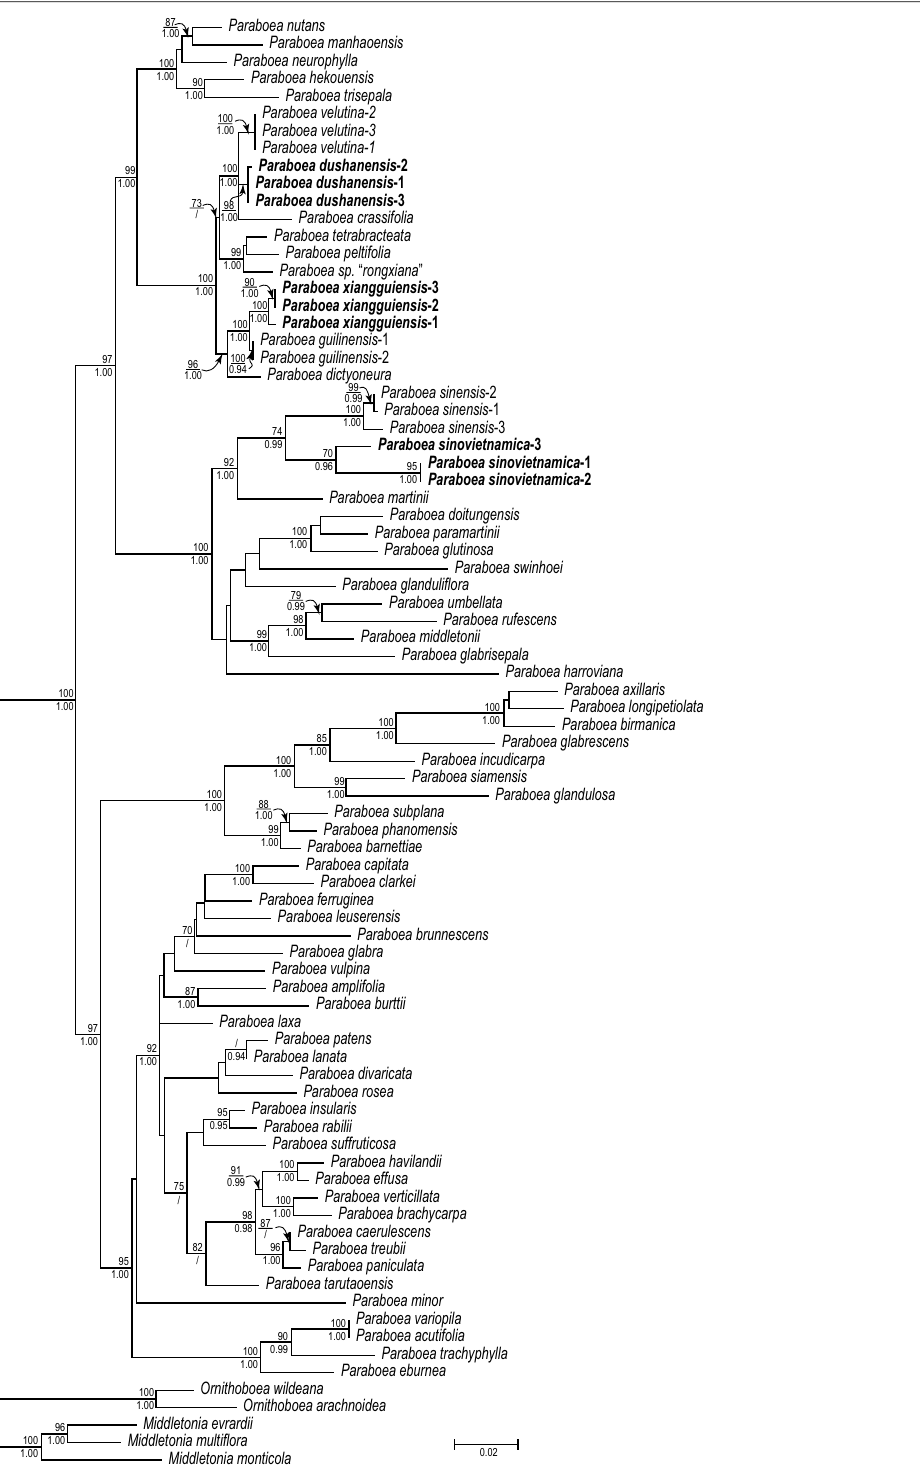
Fig. 1 The best ML tree from the analyses of the combined ITS and chloroplast trnL ‑ F regions. ML bootstrap support values (> 70%) and Bayesian posterior probability > 0.90 are shown above and below the branch around the corresponding node. The three new species are highlighted in